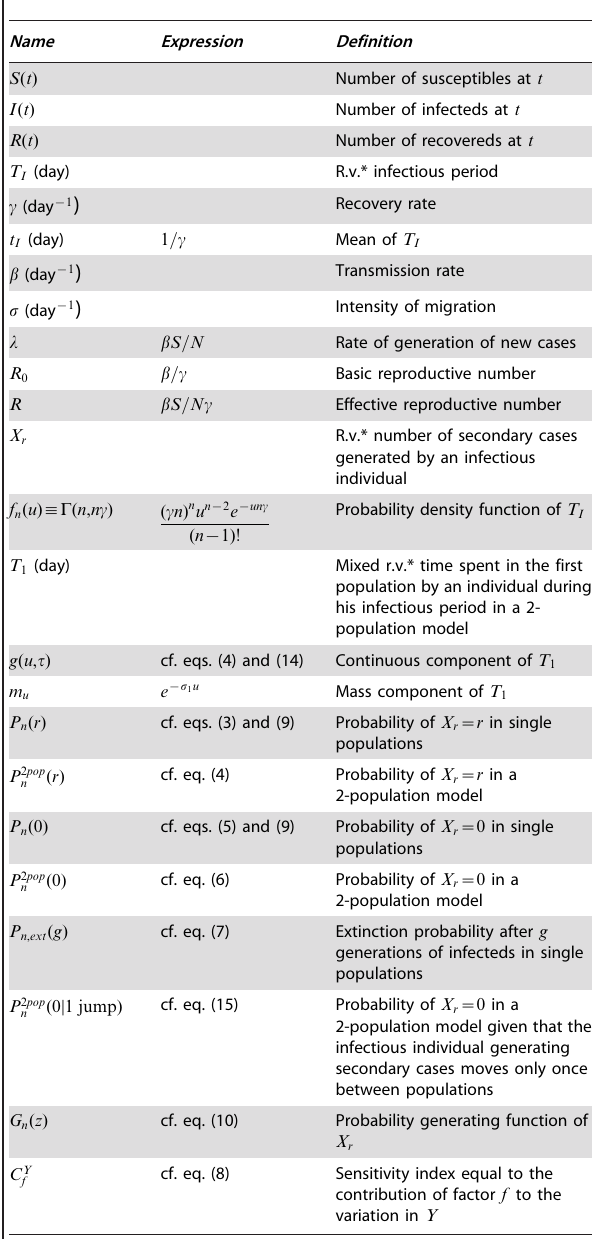
Table 1. Summary of important parameters, variables and